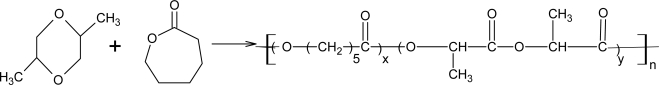
Synthesis of (PCLA) [24].